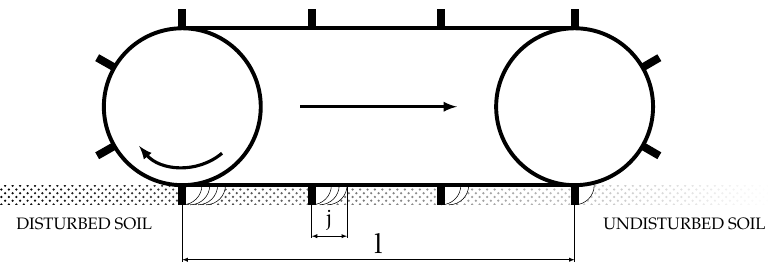
Figure 2. Shear displacement developing under a track